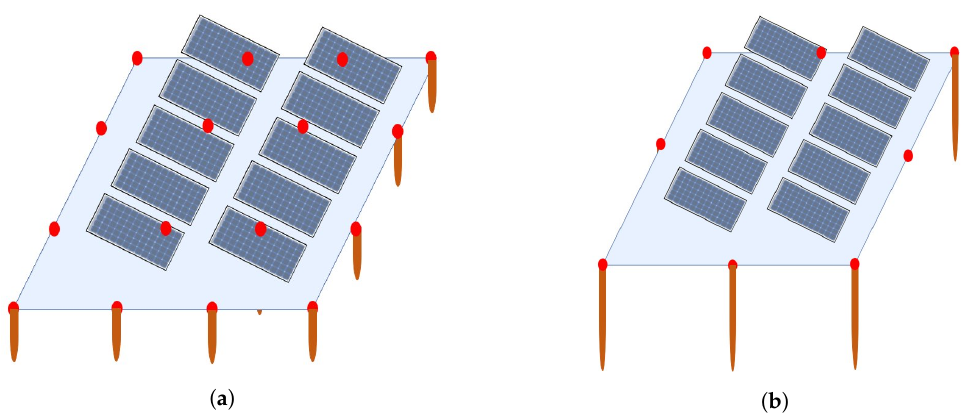
Figure 13. Arrangement of electrodes in a 3-kW floating PV system: ( a ) 16 copper electrodes (0.5 m) and ( b ) six copper electrodes (1.8 m).